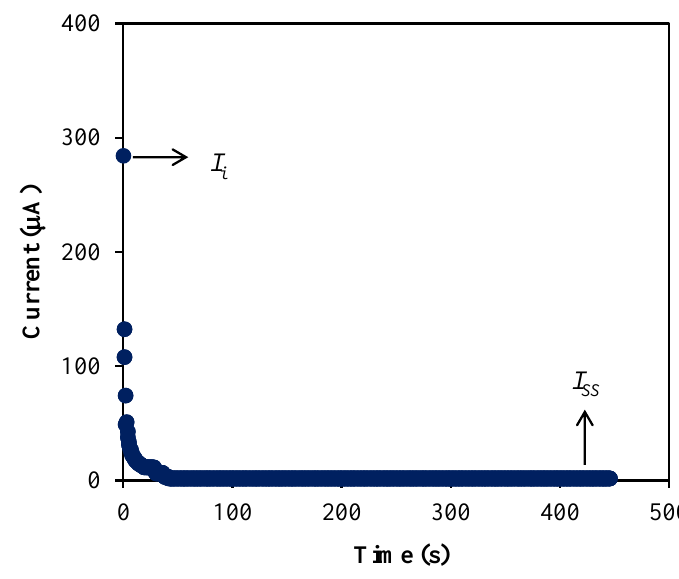
Figure 7. The plot of current versus time for the A3 electrolyte.